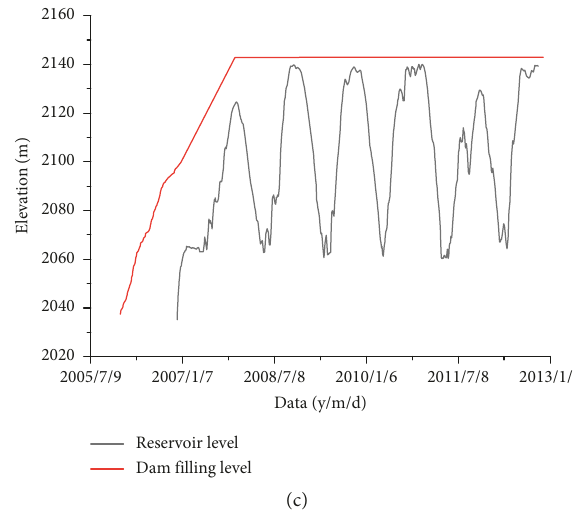
Figure 2: Information of the Qiaoqi gravelly soil core rockfill dam. (a) Maximum cross section and layout of monitoring gauges. (b) Longitudinal section. (c) Dam construction and reservoir impounding process.